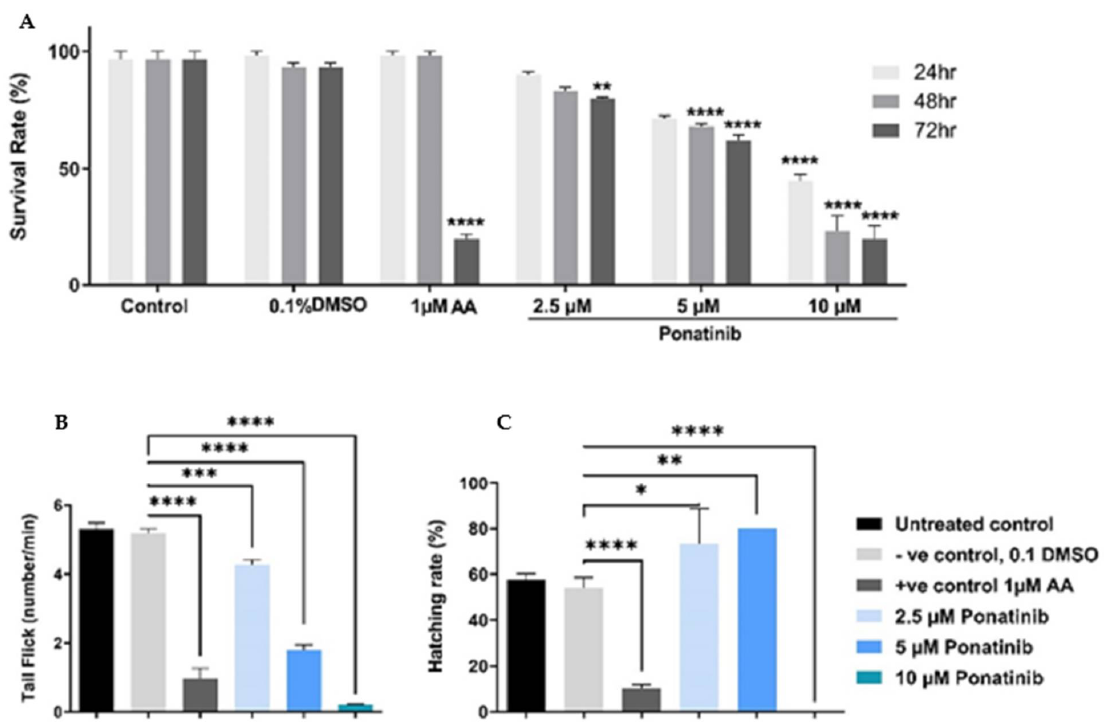
Figure 4. Mortality and visible morphological changes in Ponatinib-treated zebrafish embryos. ( A ) The survival rate of embryos exposed to different concentrations of Ponatinib compared to the Pos- itive control (Aristolochic acid -AA) and NC (0.1% DMSO), at different timepoints: 24, 48, and 72 hpf, n = 20. ( B ) Assessment of potential neuro/muscular toxicity at 24 hpf by locomotion/tail-coiling assay. The plot represents the average tail coiling (burst/min) measured by DanioScope software. n = 20. ( C ) Ponatinib effect on the zebrafish embryos hatching rate n = 20. D’Agostino and Pearson omnibus normality test was performed on all data to determine distribution. All parameters passed the test. Accordingly, a one-way-ANOVA with Sidak posthoc test was performed to compare pair: Control vs. negative control and negative control and 2.5 mm Ponatinib. * = p < 0.05, (**) = p < 0.01, (***) = p < 0.001, (****) = p <0.0001.